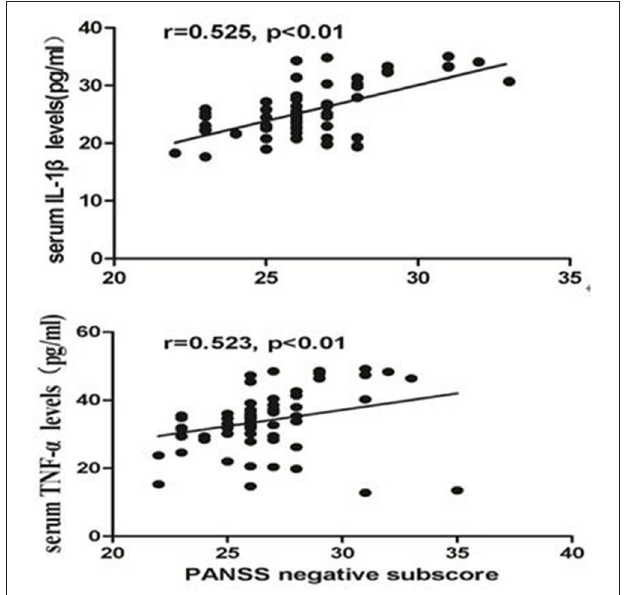
FIGURE 2 | Moderate Significant positive correlation between the serum TNF- α or IL-1 β levels and the PANSS negative subscore in chronic